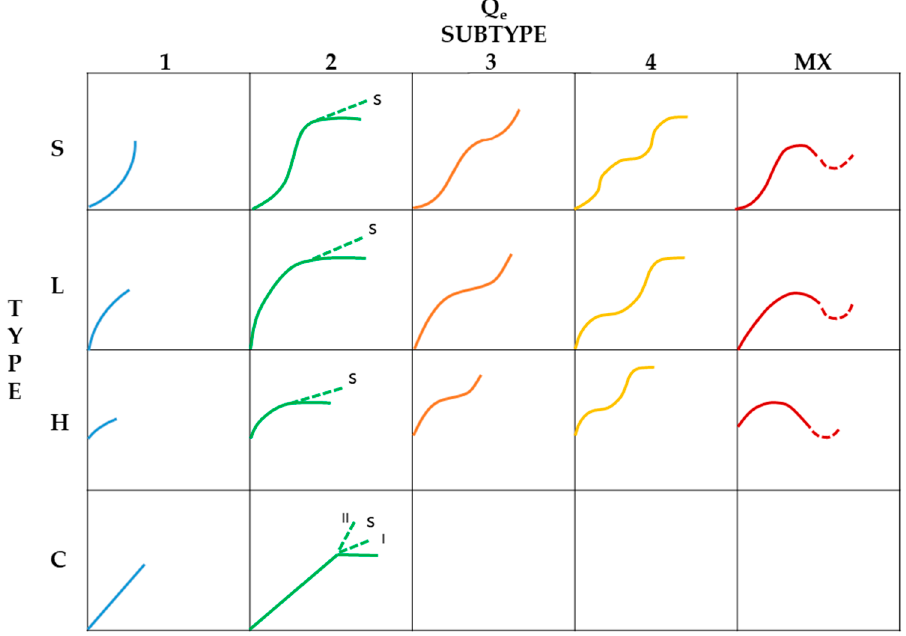
Figure 1. Isotherm classification for liquid phase proposed by Giles. Adapted and modified from [4]. S curves are convex at first, but later they become concave to the concentration axis (similar to type III or IV, according to the IUPAC classification [5]); L curves are concave to the axis of concentration (similar to type I isotherm, in line with the IUPAC classification